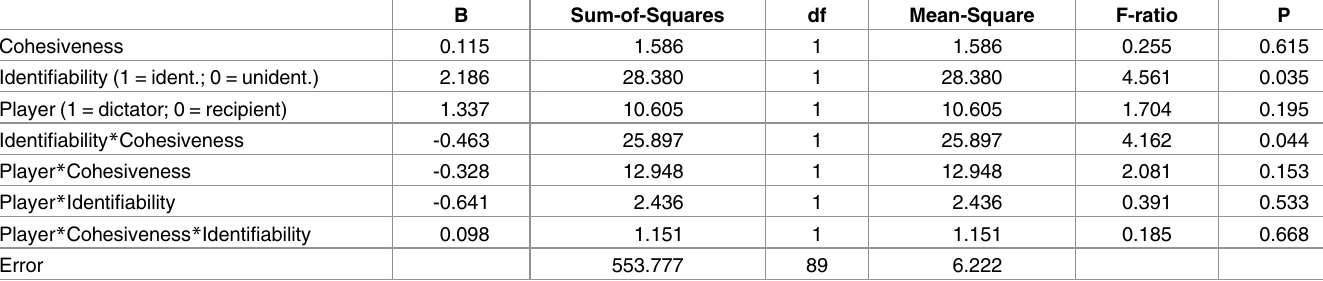
Table 1. General linear model for predicting allocation N- = 97 multiple R: 0.298 squared multiple R: 0.089.